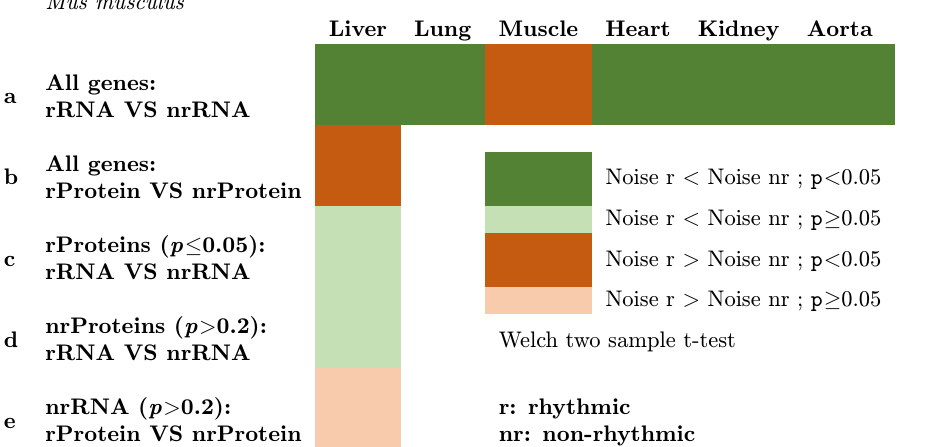
Table). We obtained similar results after controlling for gene expression bias (Table 2 and background boxes in S8 Table), since higher expressed genes are known to be more conserved genes. Interestingly, we didn’t find a clear tendency for higher conservation in rhythmic pro- teins (Table 2). In Arabidopsis, genes rhythmic at both levels were less conserved than genes rhythmic at only one level (Table 2), and results were unclear for mouse. These results suggest